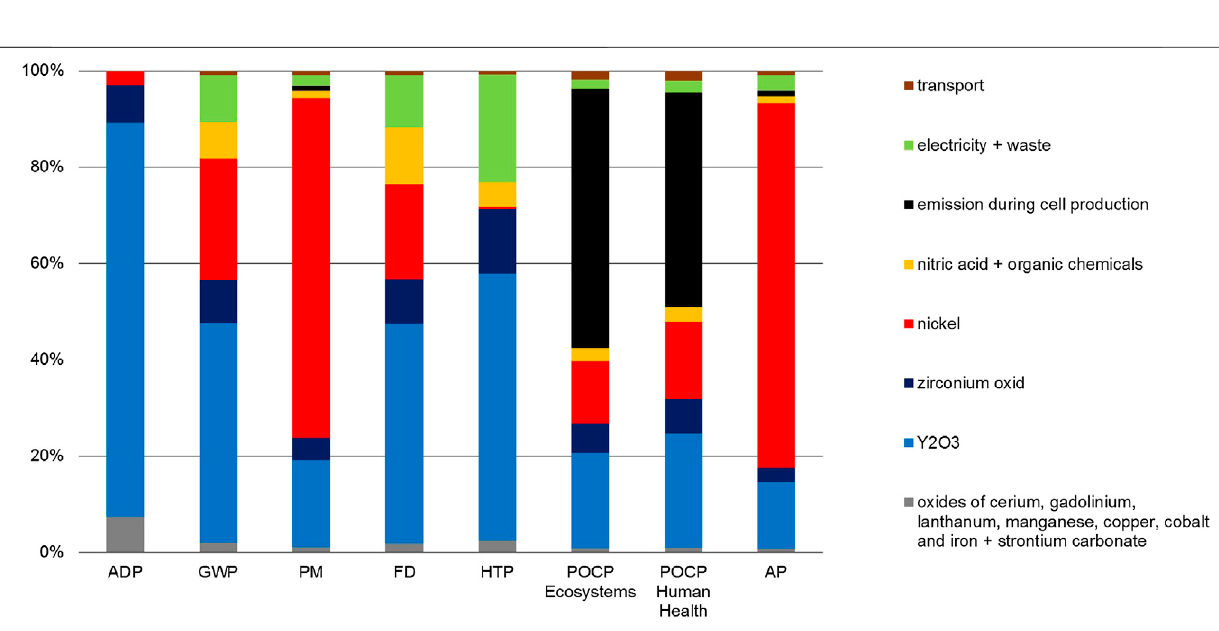
Frontiers in Energy Research |